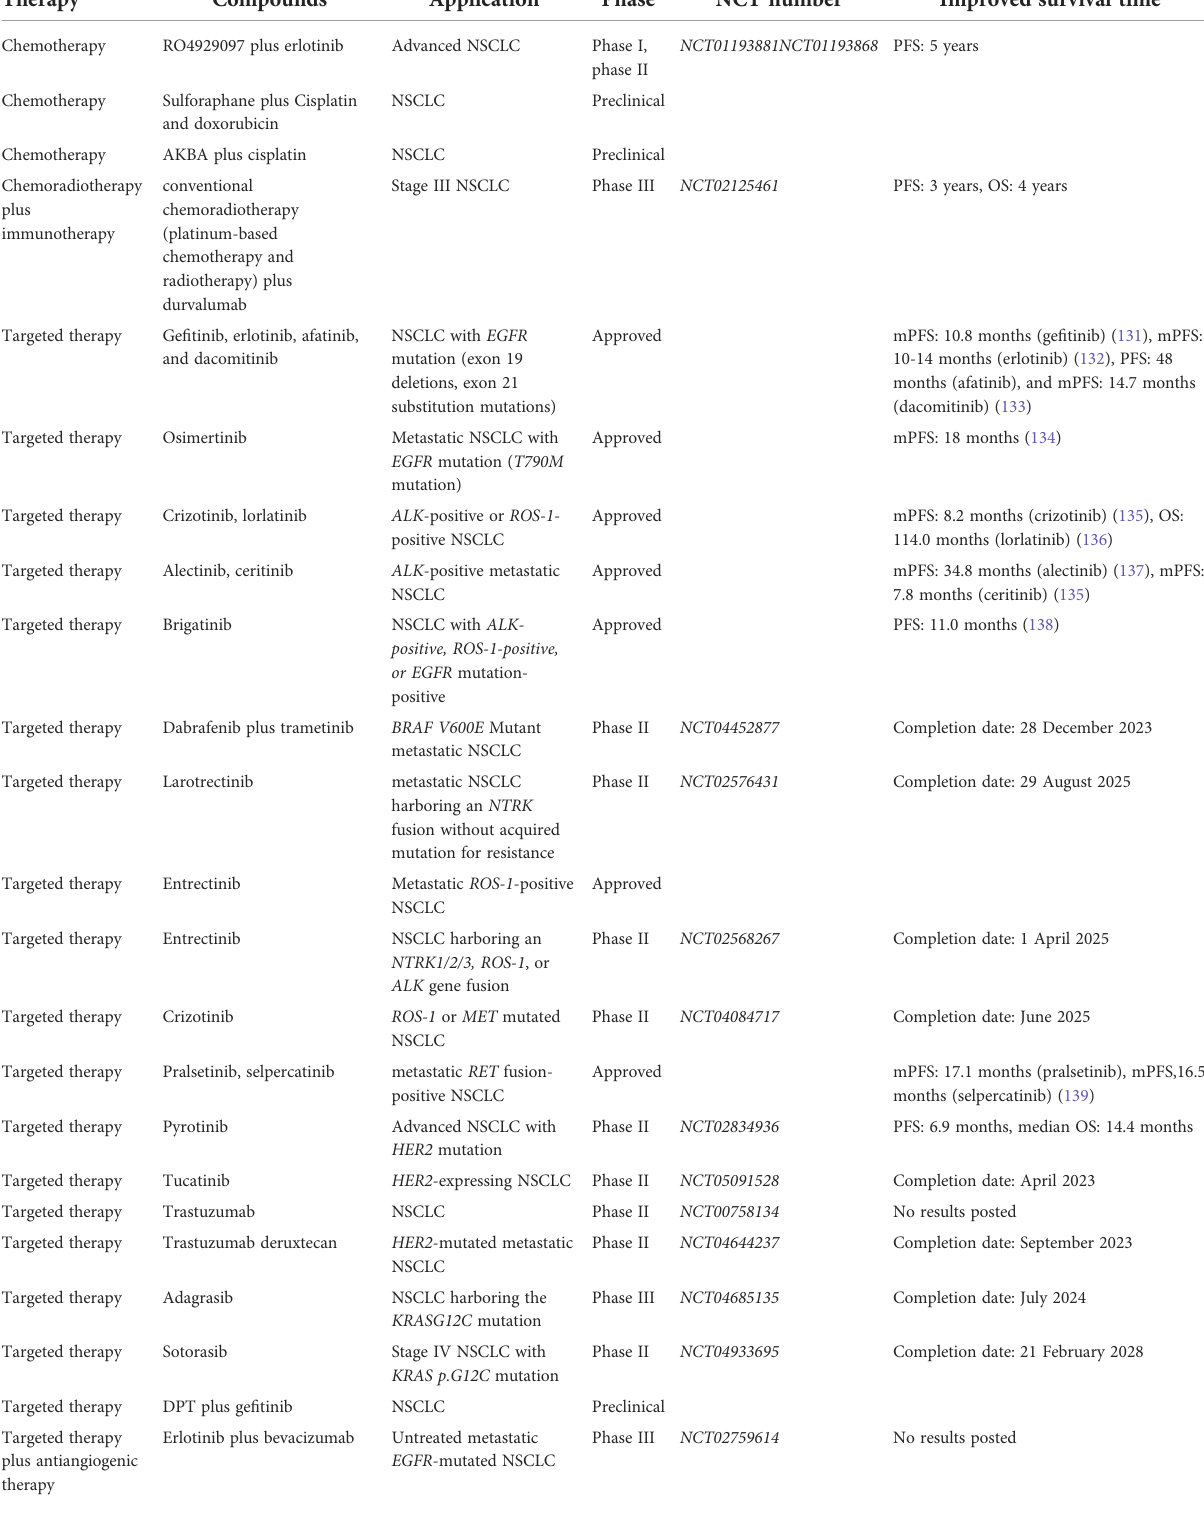
TABLE 2 Drugs used in chemotherapy and targeted